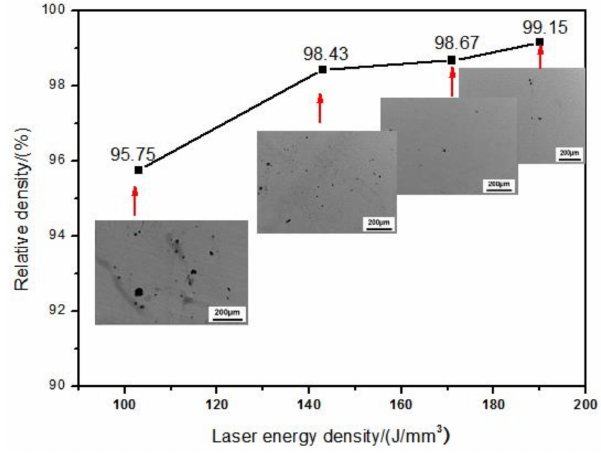
Figure 4. Effects of linear input E on the densification level of SLM Inconel 718 samples. OM images of the corresponding sample cross-sections are